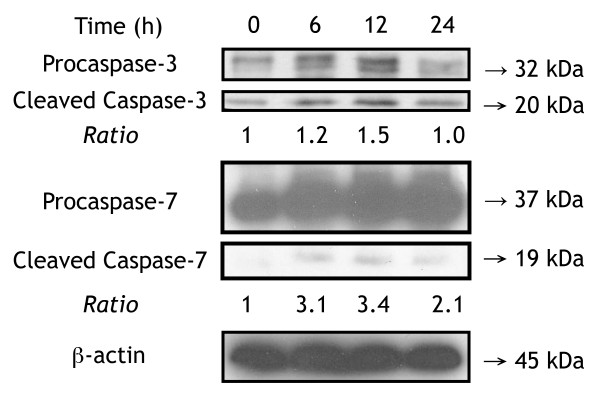
CASP3 and CASP 7 were cleaved into active forms after F3 treatment in THP-1 cells. After THP-1 cells were treated with F3 for 0, 6, 12, 24 hours, we detected proforms and active forms of CASP3 and CASP7 using western blotting. CASP3 and CASP7 were activated after F3 treatment.